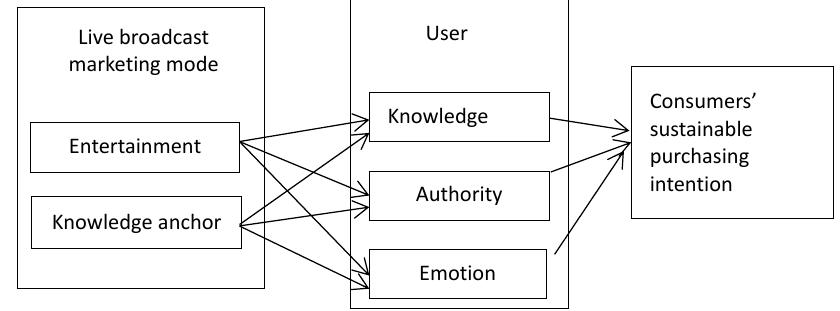
Fig. 1. Research model of direct marketing mode and consumer purchase intention of functional